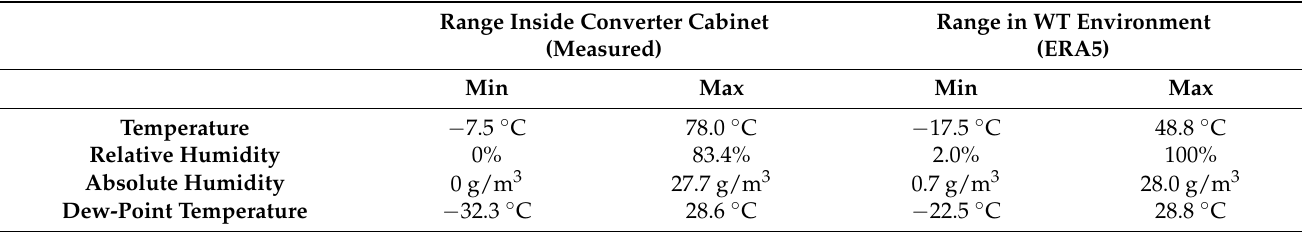
Table 1. Range of temperature and humidity conditions measured inside the converter cabinets of 31 wind turbines and extrema of WT-ambient conditions according to ERA5 data from the corresponding sites and periods. Range Inside Converter Cabinet Range in WT Environment (Measured) (ERA5) Min Max Min Max Temperature − 7.5 ◦ C 78.0 ◦ C − 17.5 ◦ C 48.8 ◦